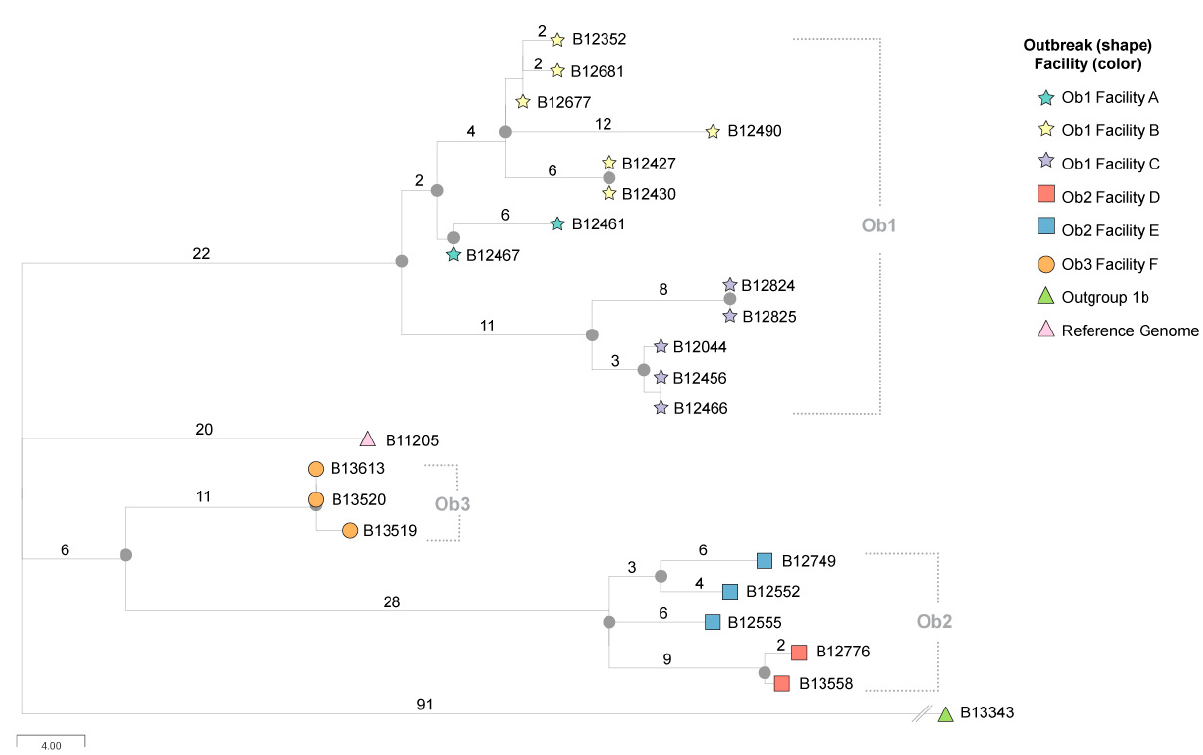
Figure 1. Phylogeny of Candida auris benchmark dataset including cases from Clade I. Numbers above the branch indicate the number of changes that have occurred in that branch length, and the internal solid circle nodes indicate separations with a bootstrap value of at least 90%. Each leaf node represents a unique isolate; the shape of the node refers to the outbreak number code and the node color refers to the facility.